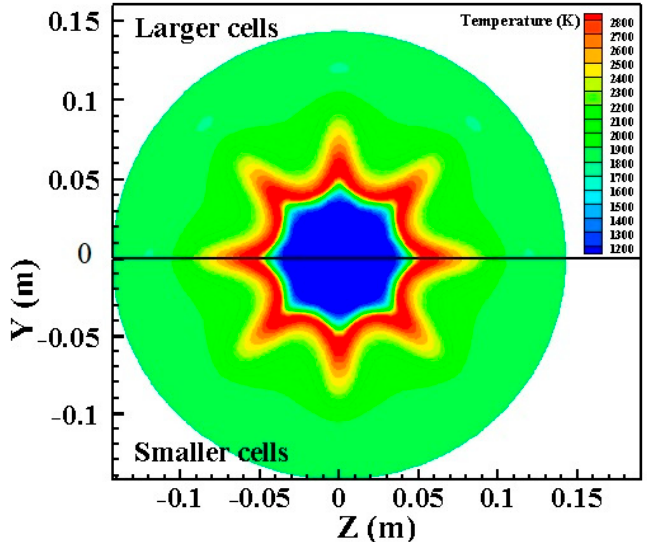
Figure 9. Temperature distribution with different meshes at the nozzle